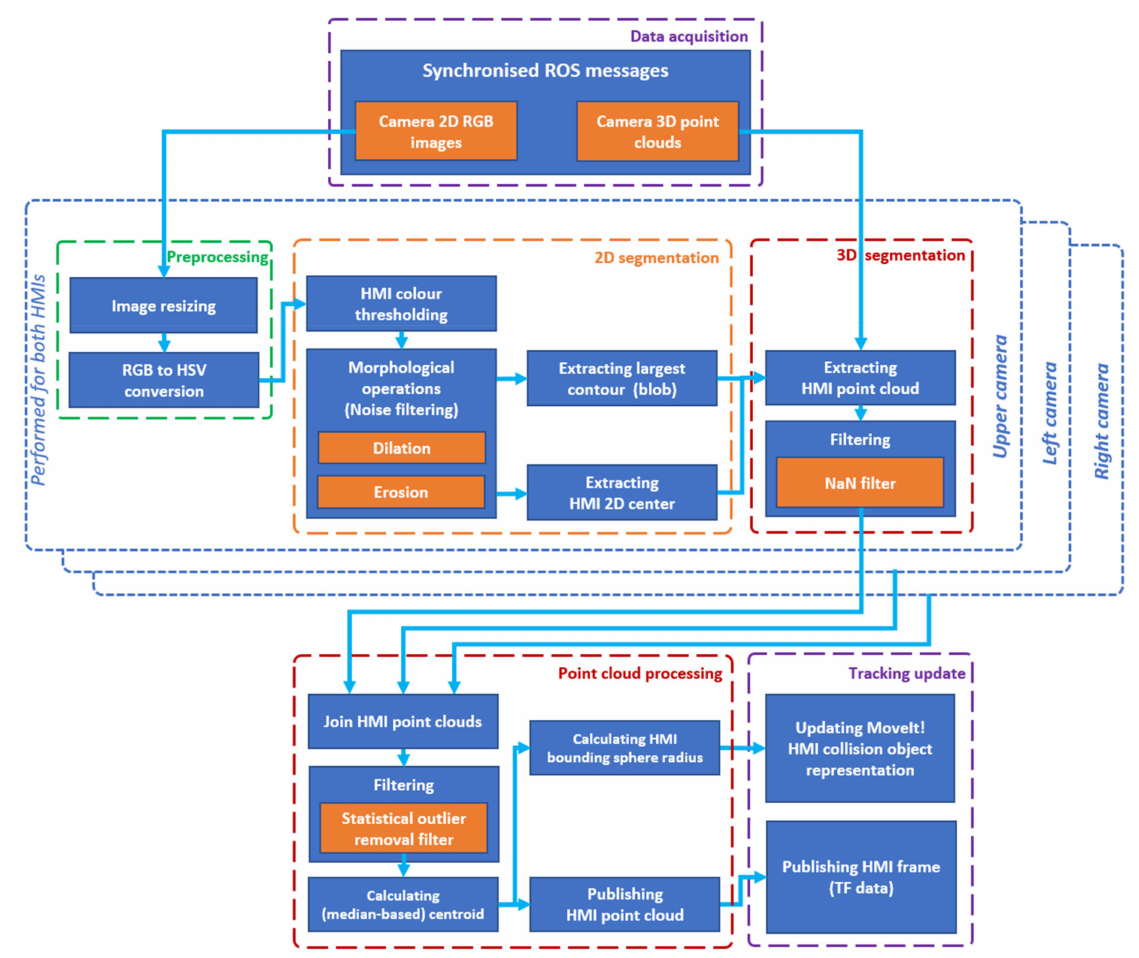
Figure 10. HMI tracker data flow